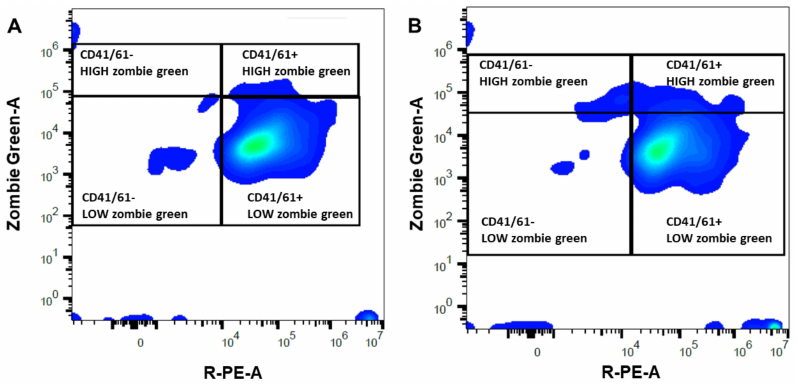
Figure 1. Representative density plot for flow cytometric analyses performed on platelet-rich ( A ) and -poor ( B ) plasma obtained from a mare susceptible to persistent-breeding induced endometritis. Platelets were identified with a primary (mouse monoclonal antibody anti CD41/61) and secondary antibody anti-mouse IgG conjugated with a fluorochrome (PE, R-phycoerythrin, X -axis) and their membrane integrity was assessed with Zombie Green ( Y -axis). The right quadrants enclosed CD41/61 positive events, presumptively corresponding to platelets, with high (damaged membrane) or low (intact membrane) Zombie Green signal. The left quadrants included CD41/61 negative events, likely debris, with high or low Zombie Green